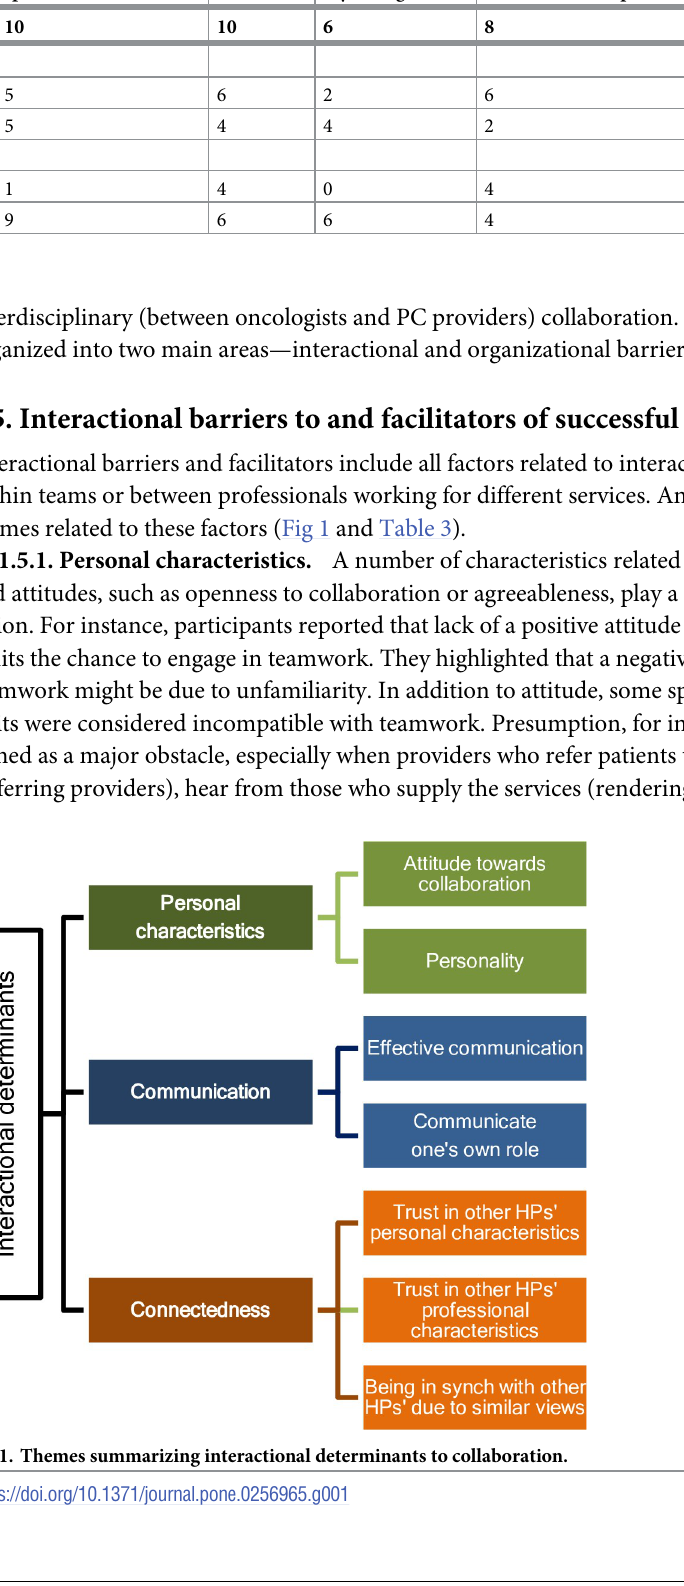
Table 2. Health care providers education and career stage. Characteristic